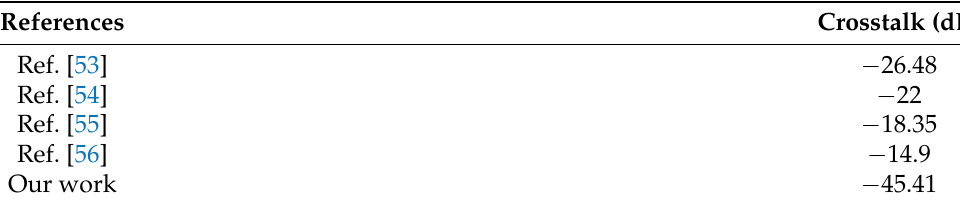
Table 1. Comparison of our results with some recent